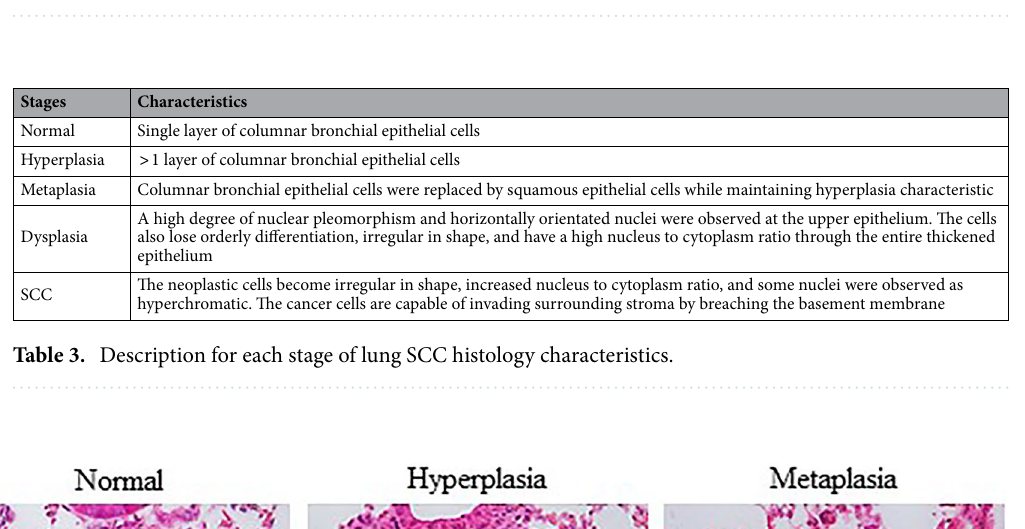
Table 2. Histopathology score of lung tissue after 30 weeks of treatment. *Significant difference ( P < 0.05) between cancer with vehicle and control groups.